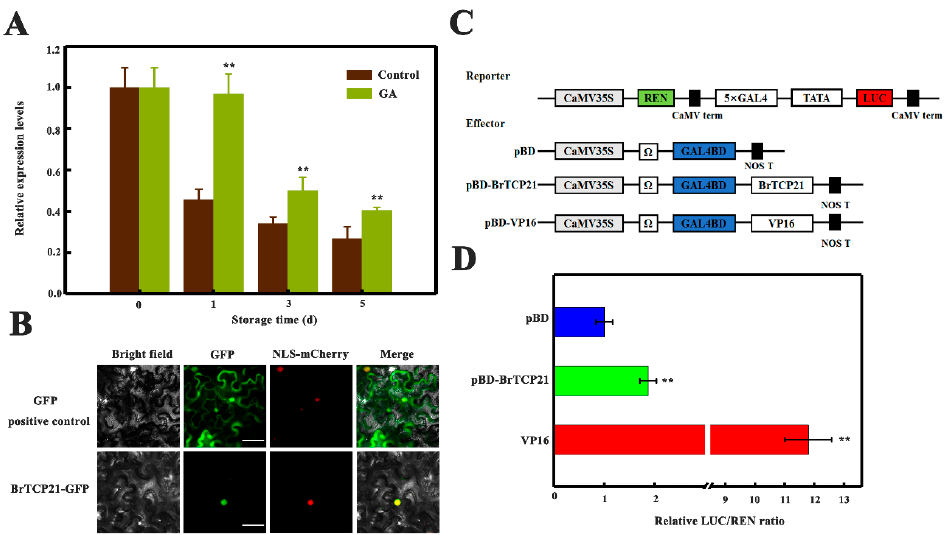
Figure 4. Molecular properties of BrTCP21. ( A ) Relative expression of BrTCP21 in control and GA 3 -treated cabbage leaves during senescence. Each value represents the mean ± S.E. of three biological replicates. Asterisks indicate a significant difference in GA 3 -treated leaves compared with control leaves (Student’s t -test: ** p < 0.01). ( B ) Subcellular localization of BrTCP21 in epidermal cells of Nicotiana benthamiana leaves. A plasmid harboring GFP or BrTCP21-GFP was transformed into with a fluorescence microscope after 2 d of infiltration. NLS-mCherry was included in each